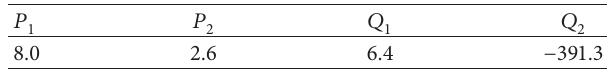
Figure 6: Absolute porosity. Table 3: Parameter values in equation (27).